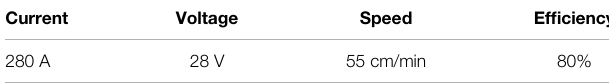
TABLE 1 | Welding parameters.